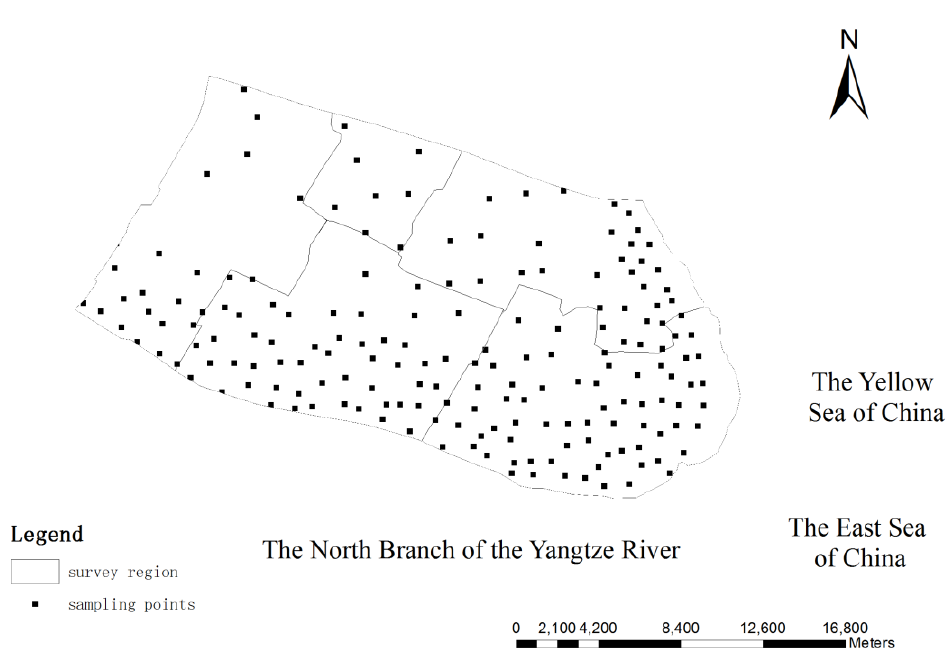
Figure 3. Survey region and distribution of soil sampling points (The black dots represented the sampling points).